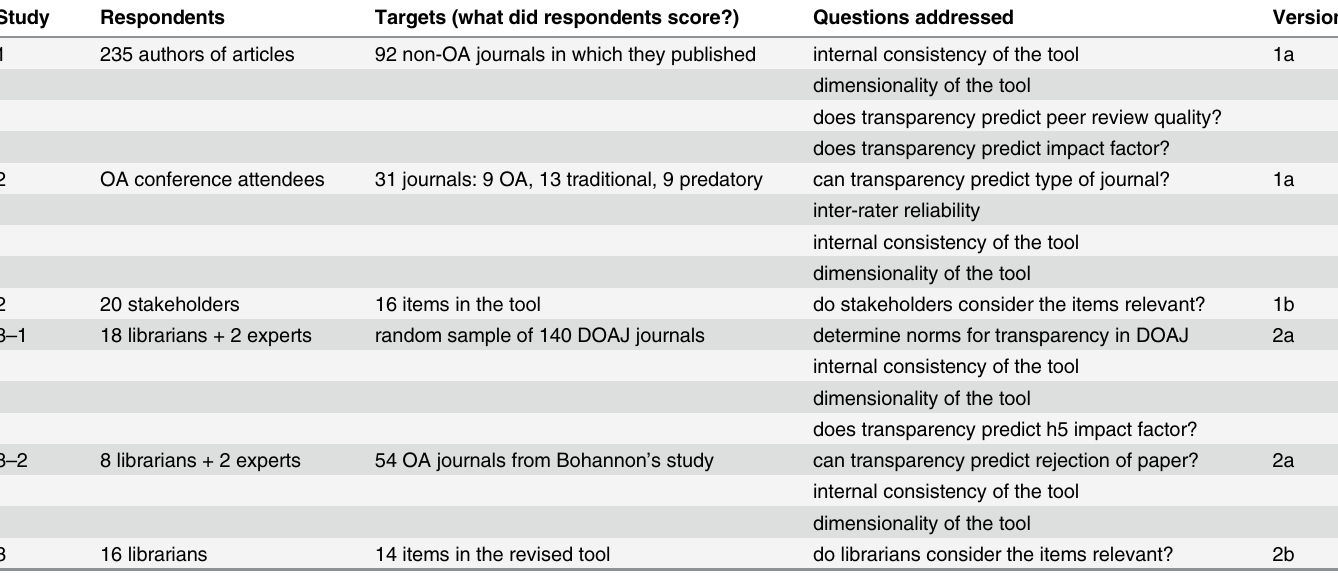
Table 1. An overview of the studies of the transparency tool and questions addressed in each